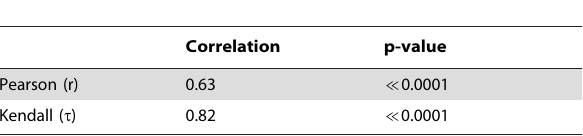
Table 2. Correlation between AutoDock 4 and Vina.